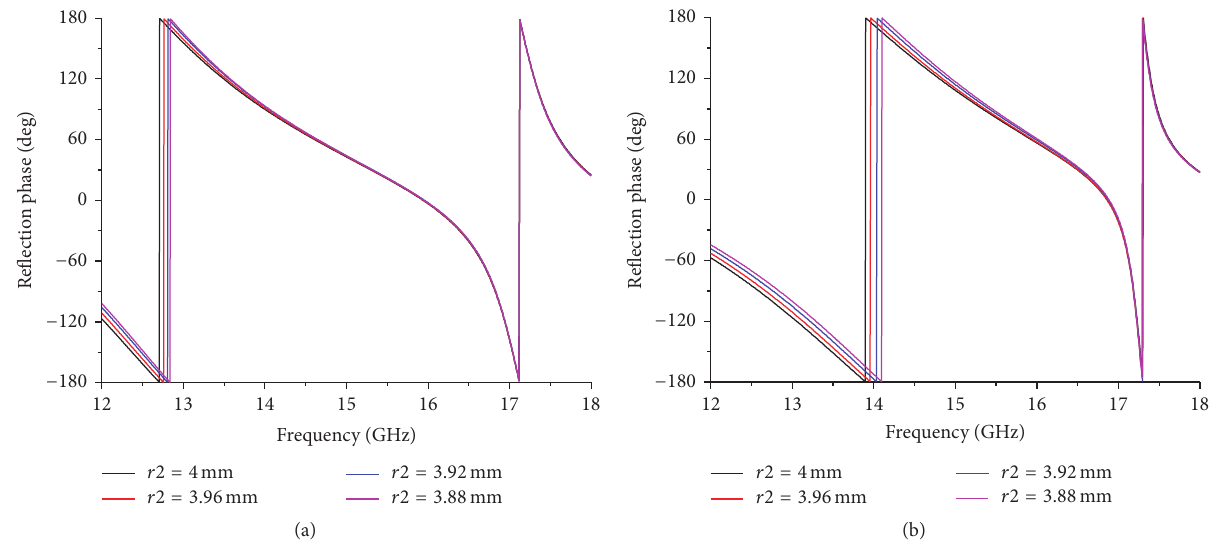
Figure 9: Reflection phase for various values of 𝑟2 : (a) under major axis polarized incidence; (b) under minor axis polarized incidence.